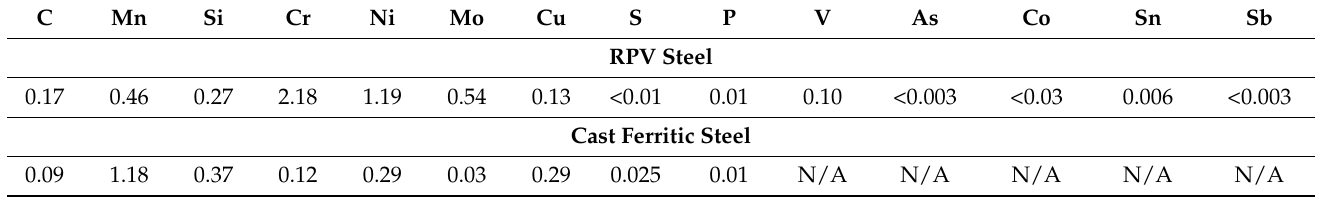
Table 1. Chemical composition of the investigated steels (wt %, remainder is Fe ).